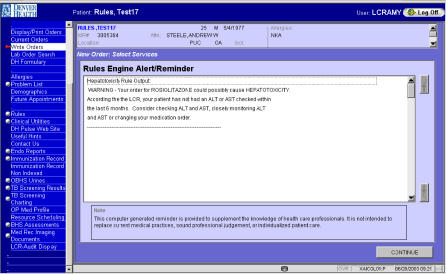
Rules Output Screen for “Recommended Laboratory Value Not Done in Last Six Months”